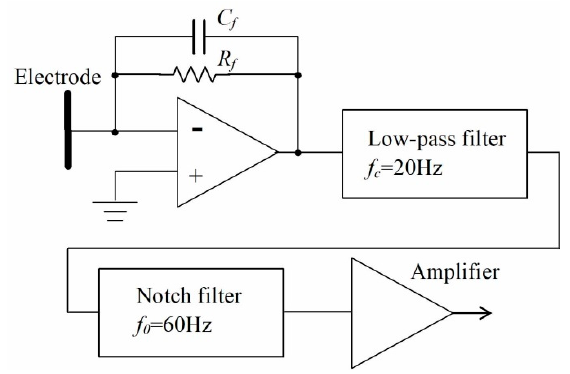
Figure 1. Block diagram of an ultrasensitive electrostatic induction sensor.